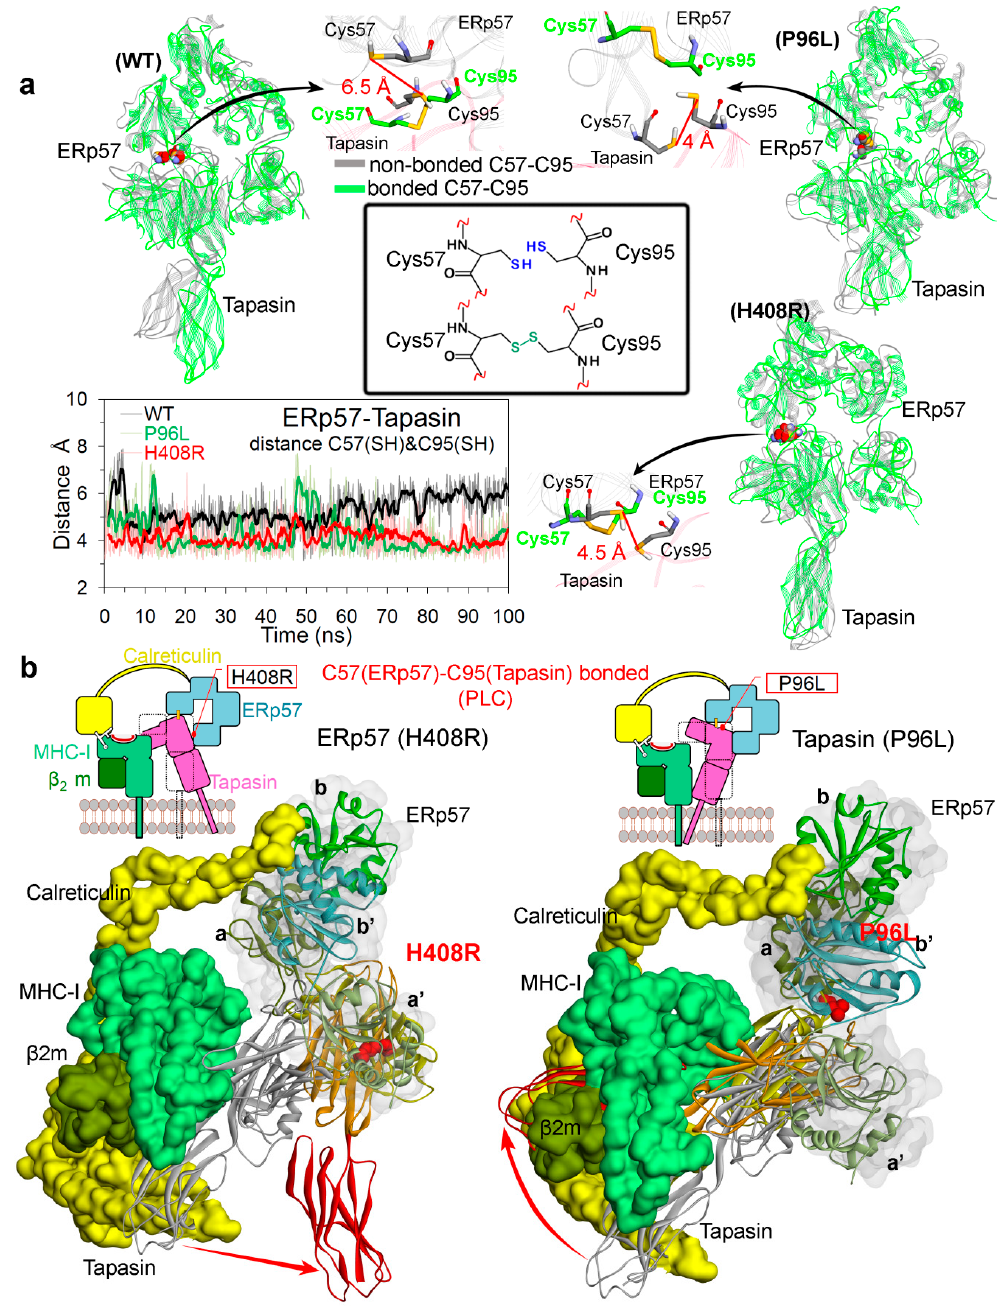
Figure 7. Conformation dynamics of the ERp57-tapasin complex. ( a ) Distance between Cys57(ERp57)-Cys95(tapasin) in the absence of disulphide bond, and conformations of residues and ERp57-tapasin complex compared with disulphide bonded and non-bonded form (coordinates extracted from the end of the MD simulations). ( b ) Structure extracted from the end of the MD simulation and compared with the PLC complex (PDB: 6ENY [4]). ERp57 or tapasin coloured in grey are wild-type from PDB: 6ENY [4], and with their domains coloured are from mutated systems (extracted from the MD simulations). Colour scheme: oxygen in red, hydrogen in silver, nitrogen in blue, and sulphur in orange.